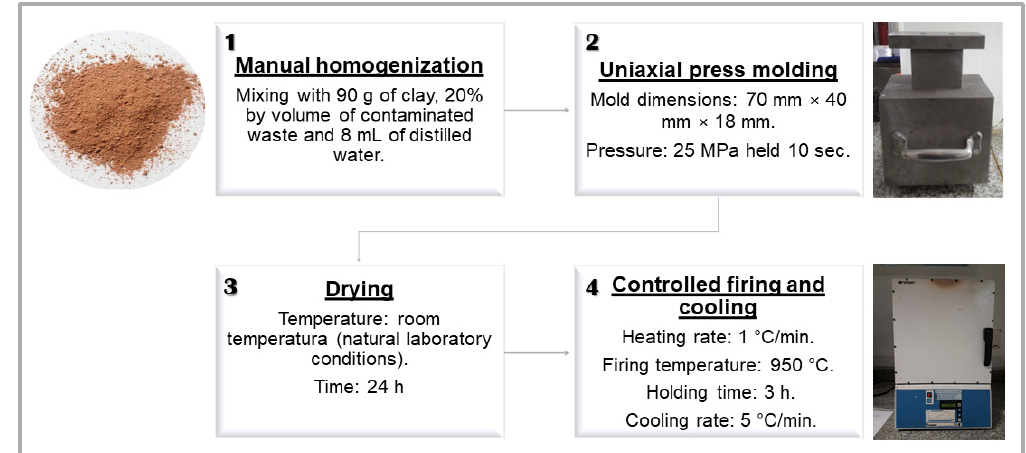
Figure 2. Clay ceramics preparation process.